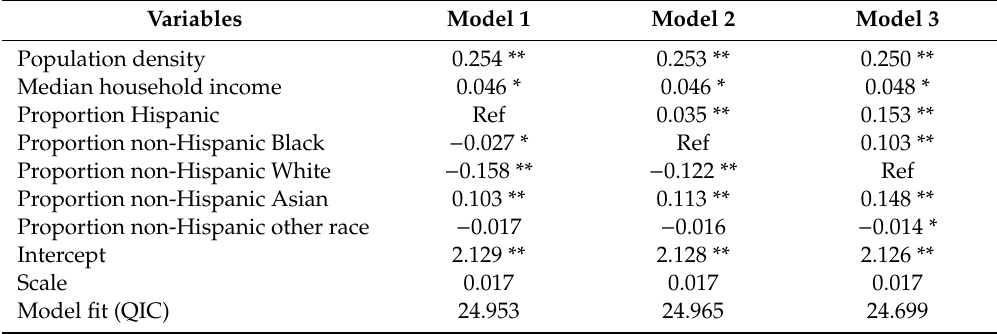
Table 3. Multivariate generalized estimating equation (GEE) analysis of on-road lifetime cancer risk (LCR): Beta coe ffi cients. QIC = quasi-likelihood under the independence criterion. Variables Model 1 Model